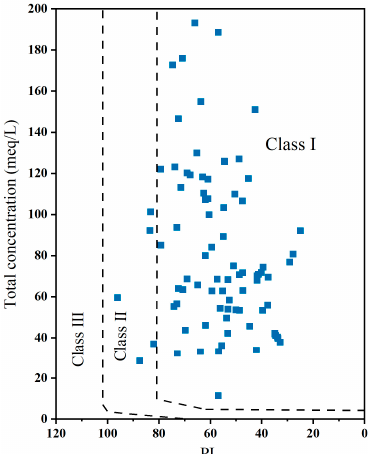
Figure 12. Doneen diagram of groundwater irrigation water quality.